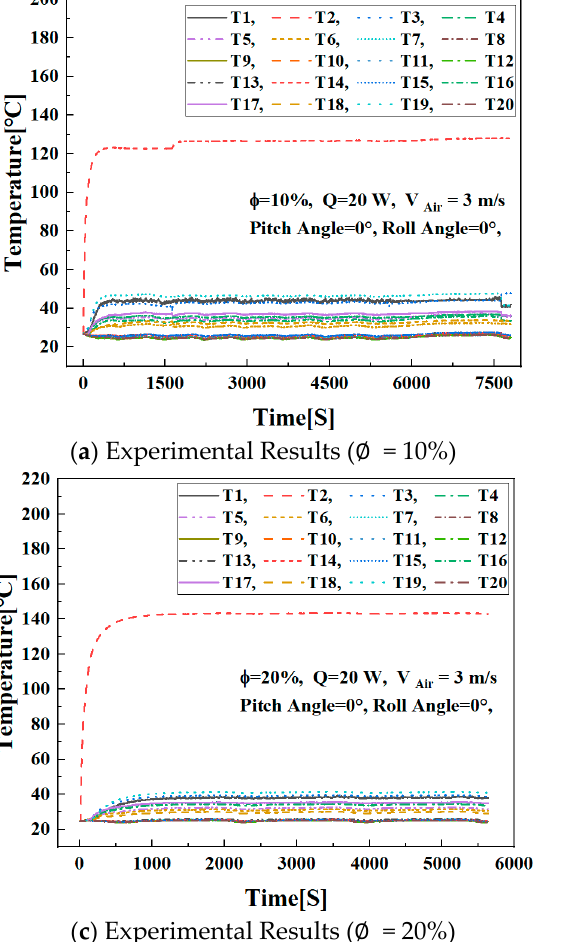
Figure 10. Transient temperature distribution of the CAHP ( V air = 3 m/s, Q = 20 W, pitch angle = 0°, and roll angle = 0°).